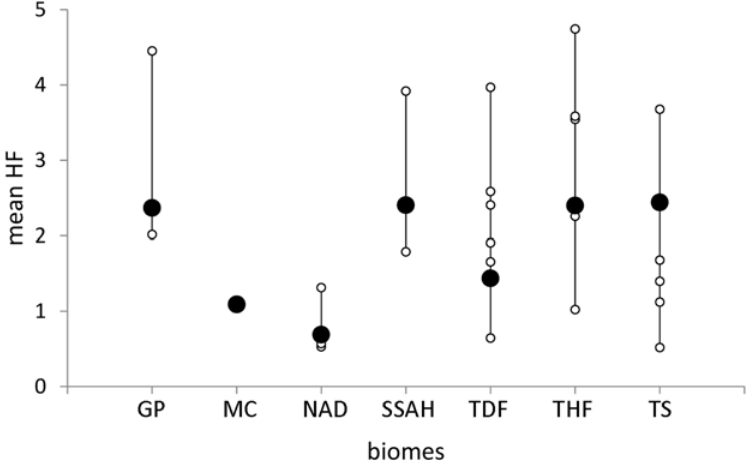
Fig 4. Statistical properties of the ecoregional human footprint. (a) Relationship between the mean human footprint in each of 24 Mexican ecoregions, and the standard deviation of their footprint values ( r 2 = 0.99; P < 0.00001). (b) Relationship between mean human footprint in each ecoregion and the skewness of the distribution of footprint values ( r 2 = 0.87; P < 0.00001). (c) Relationship between mean human footprint and the mean patch size of low footprint area in each ecoregion ( r 2 = 0.84; P < 0.00001; in all cases the fitted curve was obtained using polynomial regression).